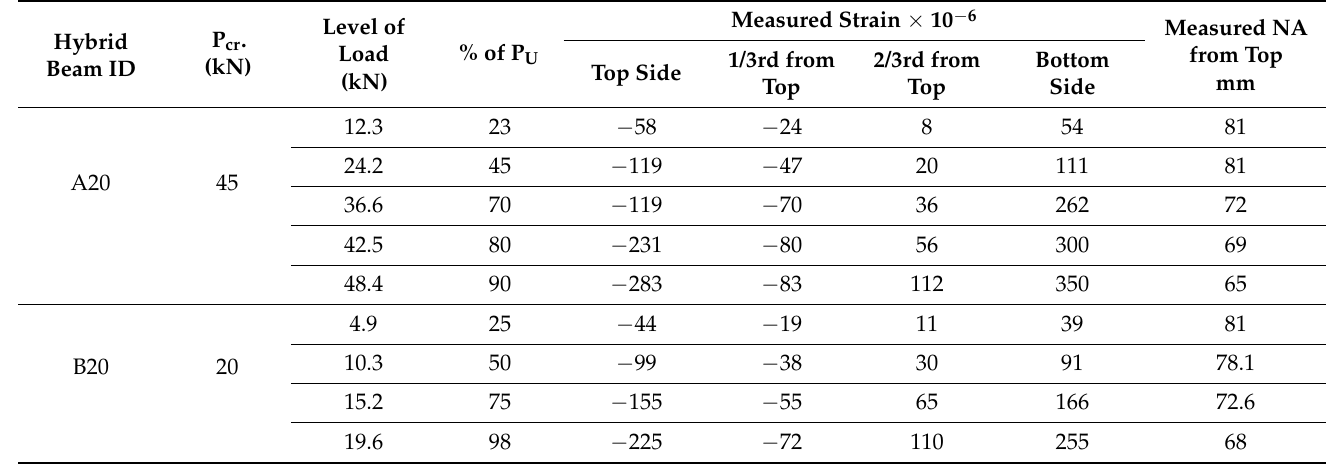
Table 7. Experimental results of load and strain for beams A20 and B20.